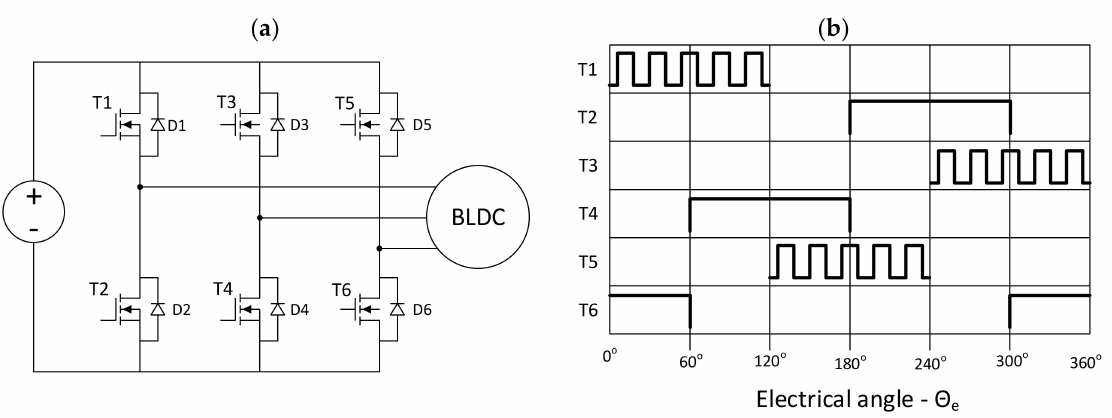
Figure 1. Circuit ( a ) control method and ( b ) BLDC motor transistors according to six step asyn- chronous PWM strategy.